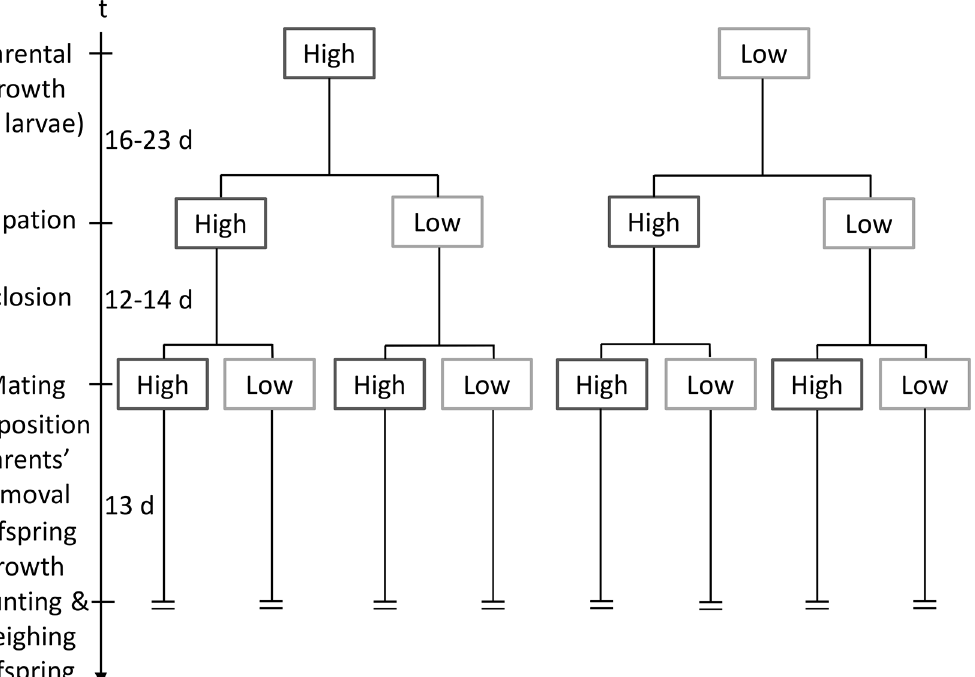
Fig 1. A scheme of the experimental full-factorial design of the diet experiment. Flour beetles were raised under higher and lower temperature (34°C and 26°C) and yeast-rich and yeast-poor diet (10% and 1% yeast) for 16 – 23 days till pupation (for exact larval stage duration see Methods). They were then kept under the same conditions or switched upon pupation to the opposite conditions for 12 – 14 days, and then crossed again between these two conditions for mating, resulting in eight treatment combinations. Offspring were raised under their parents' mating conditions. They were counted and weighed 13 days after the parental mating. Both diet and temperature experiments are similarly designed, with "High" = the 34°C or yeast-rich diet, and "Low" = the 26°C or yeast-poor diet, as the two parental growth, adult and mating/offspring growth conditions.